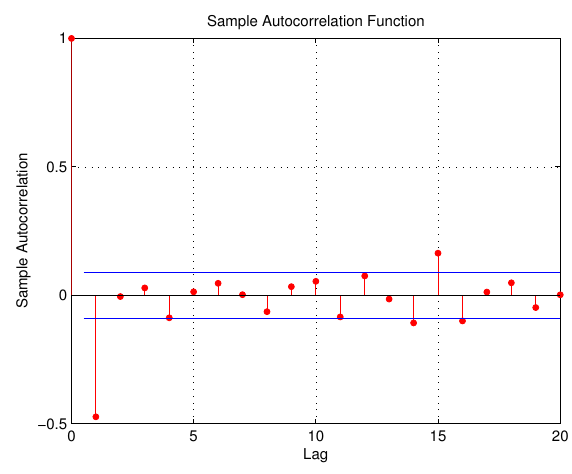
Figure 5: Interarrival times autocorrelation function tion. It computes the autocorrelation coefficients and plots them as a function of the lag. If the data are independent (uncorrelated) then the correlations should be near zero for all lags. We can see in the figure that the coefficients are not close to zero for many lags, that exhibit the long range dependence of the video streaming inter-arrival